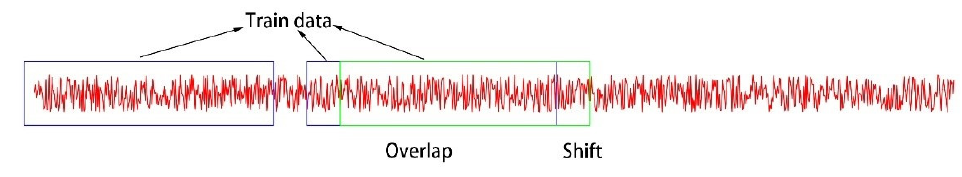
Figure 11. Sliding window for data enhancement.